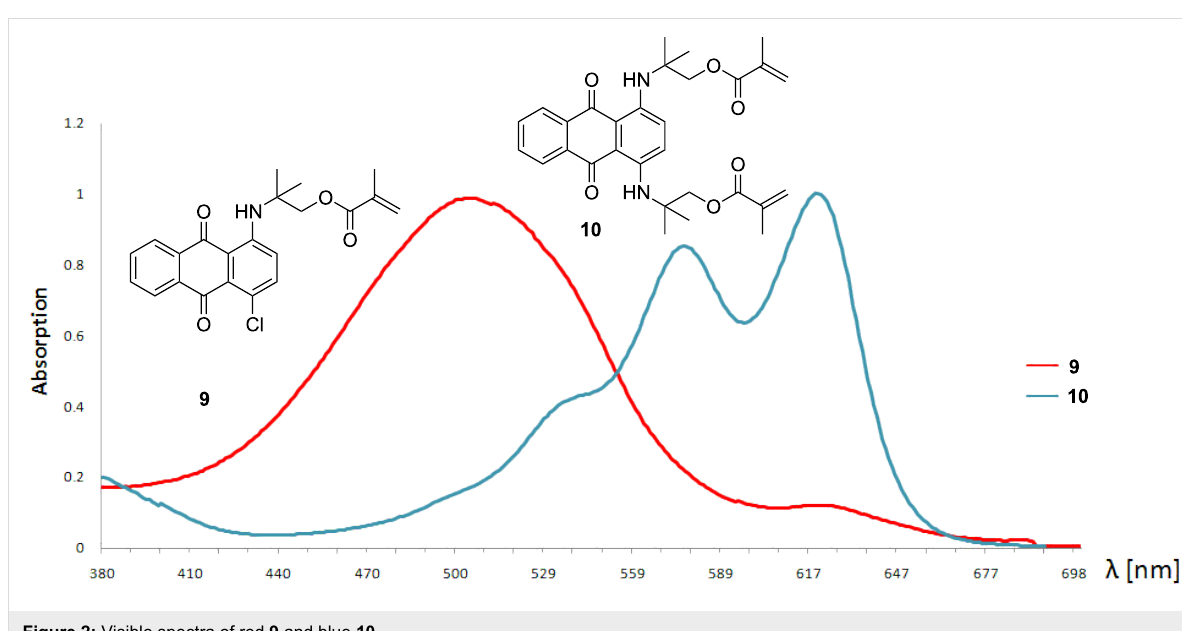
Figure 2: Visible spectra of red 9 and blue 10